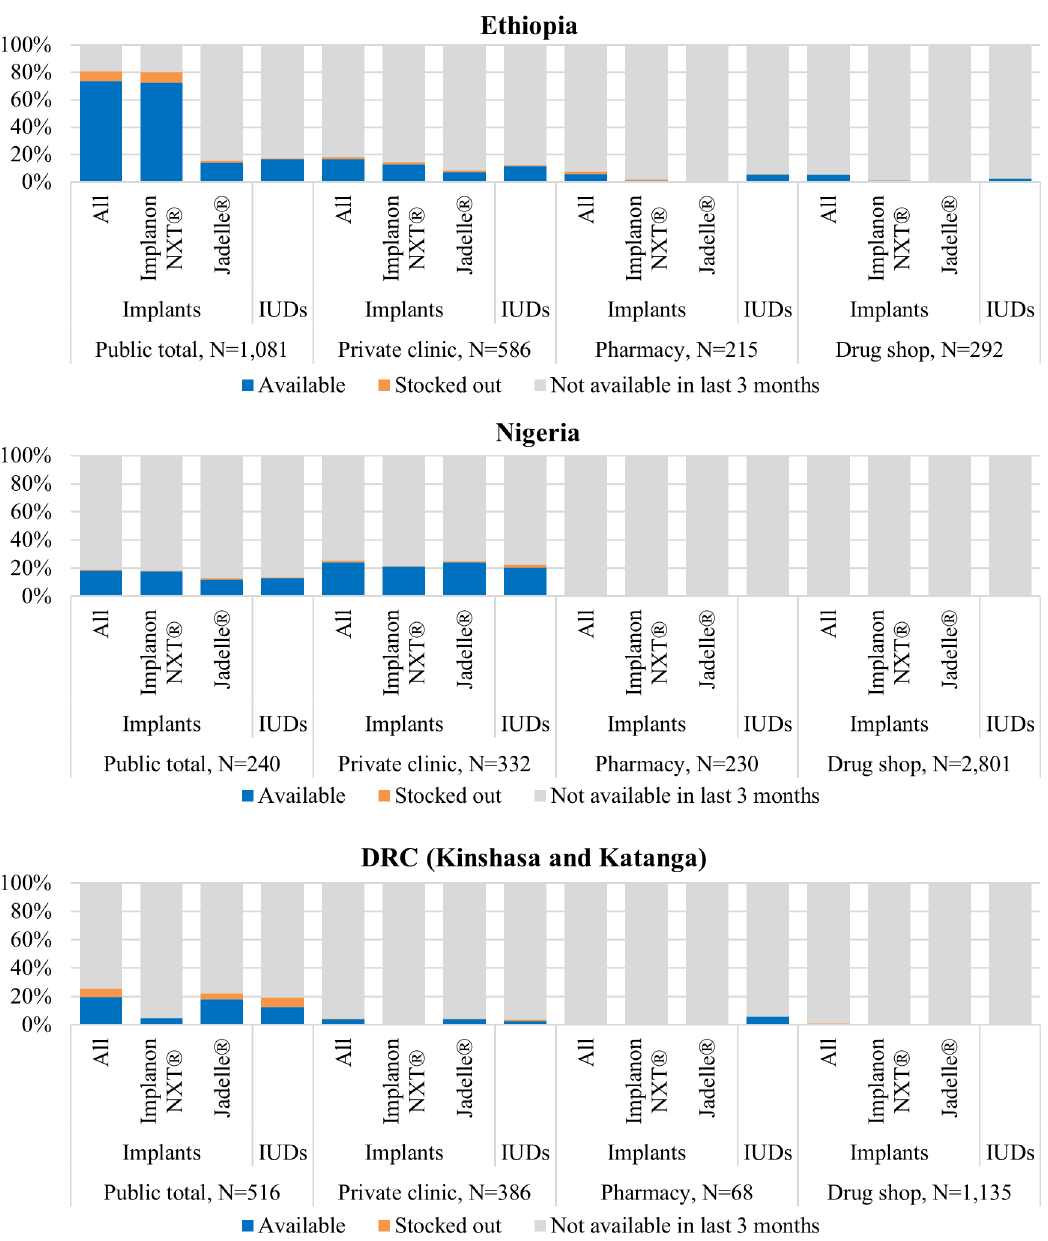
Fig 3. Availability of selected LARC methods on the day of the survey among all screened outlets excluding general retailers, by country and outlet